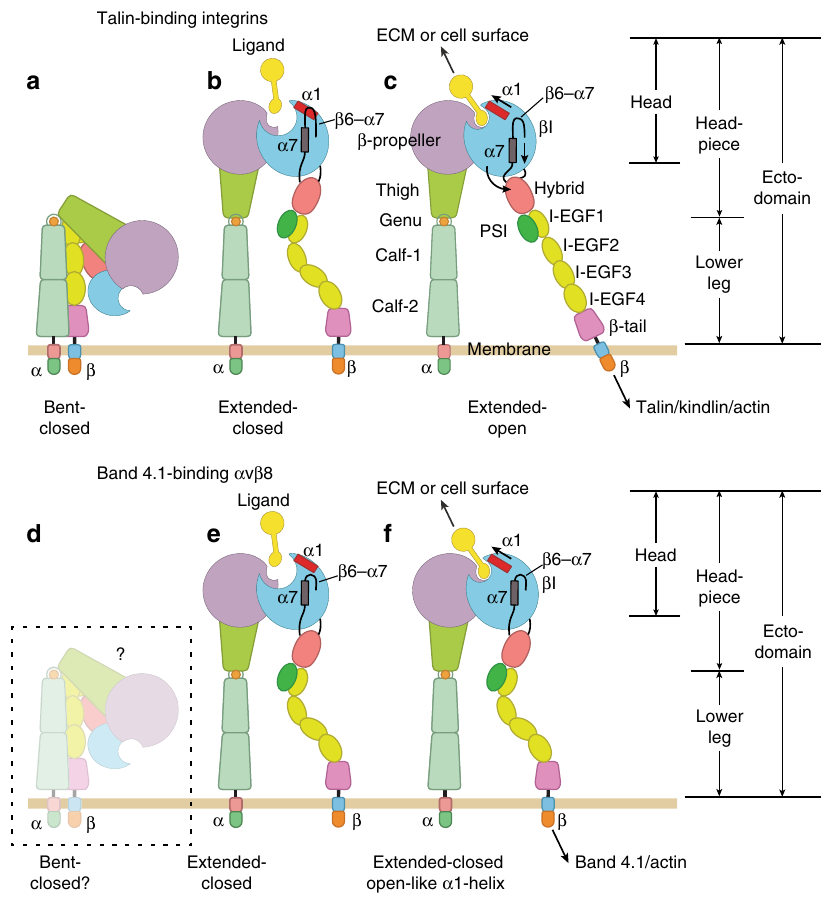
Fig. 1 Overall integrin conformational states. a – c Talin-binding integrins. d – f Band 4.1-binding integrin α V β 8. d Population of the bent-closed conformation is very low in α V β 8 14 – 16 , whereas this is by far the most populous state on cell surfaces in typical integrins ( a ) 9 . e The extended-closed conformation is by far the most populous α V β 8 conformation, at least in solution 14 – 16 . f α V β 8 does not exhibit a ligand-stabilized extended-open conformation like typical integrins ( c ). However, ligand binding induces movement of the α 1-helix (and SDL1, which includes the N-terminal portion of the α 1-helix and its preceding loop) toward the open state of the β I domain. The β 6- α 7 loop in the β I domain is unengaged with the α 7-helix, enabling opening of the β I domain to occur in the absence of hybrid domain